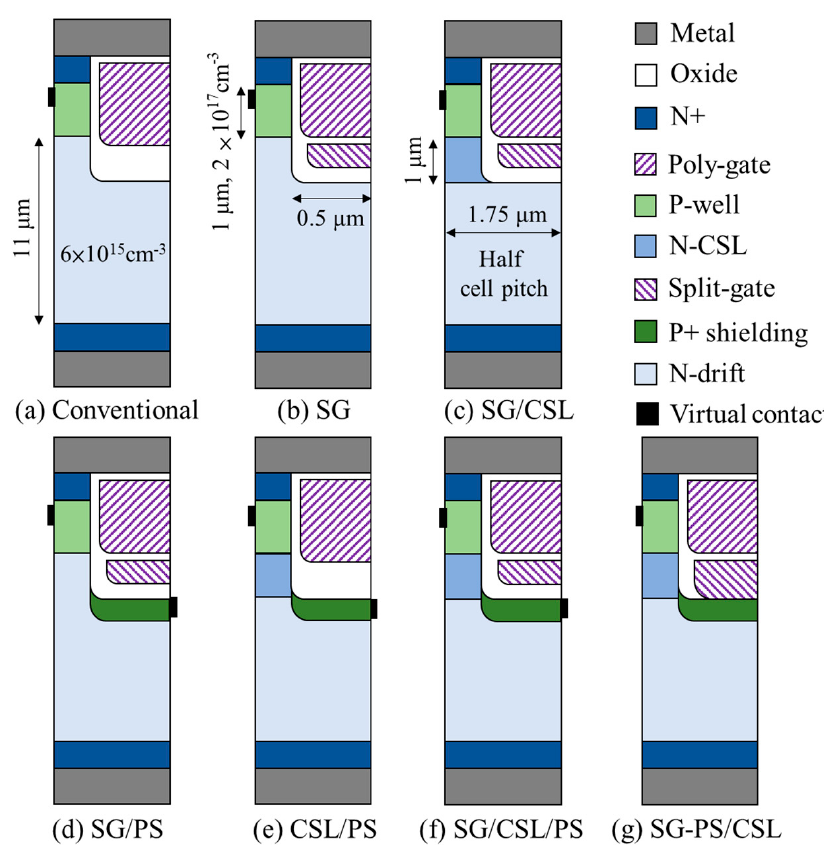
Figure 1. Schematics of different gate structures studied in this paper. A novel proposed UMOSFET with SG in contact with PS structure is shown in ( g ). All devices have a cell pitch of 3.5 μ m. ( a ). Conventional; ( b ). SG; ( c ). SG/CSL; ( d ). SG/PS; ( e ). CSL/PS; ( f ). SG/CSL/PS; ( g ). SG-PS/CSL.